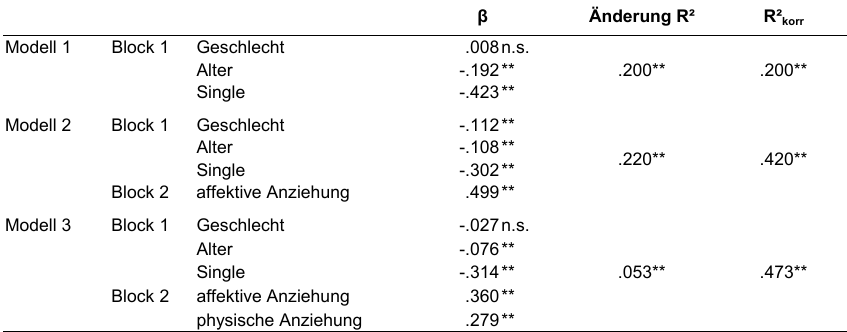
Tabelle 3: Multiple lineare Regression auf